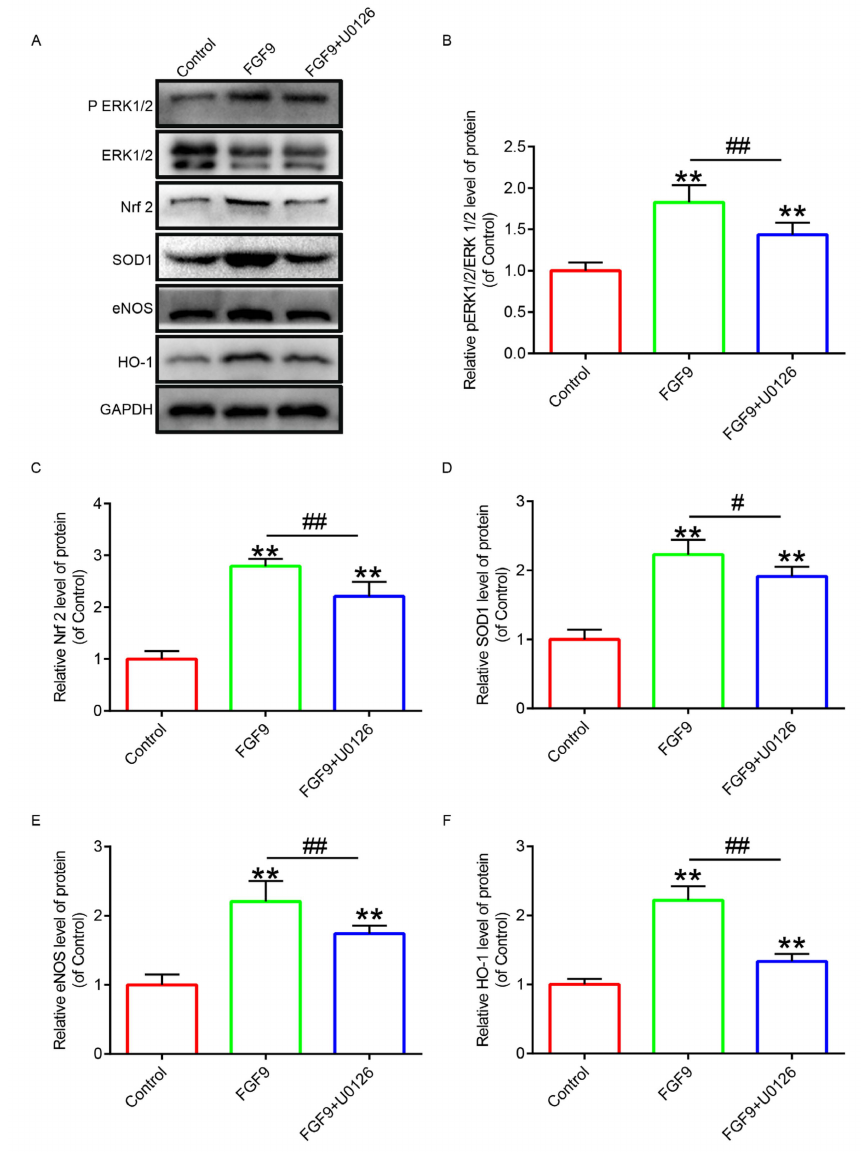
Figure 6. FGF9 significantly inhibited oxidative stress in random flaps. ( A ) Western blotting images of ERK1/2, Enos, HO-1, and SOD1 proteins. ( B – F ) Quantitative statistics of the optical density values of the these proteins. ** represents p < 0.01 versus the control group; # and ## represent p < 0.05 and p < 0.01 comparing the FGF9 group with the FGF9+U0126 group, respectively, indicating statistical significance. Data are the mean values ± SD, n =